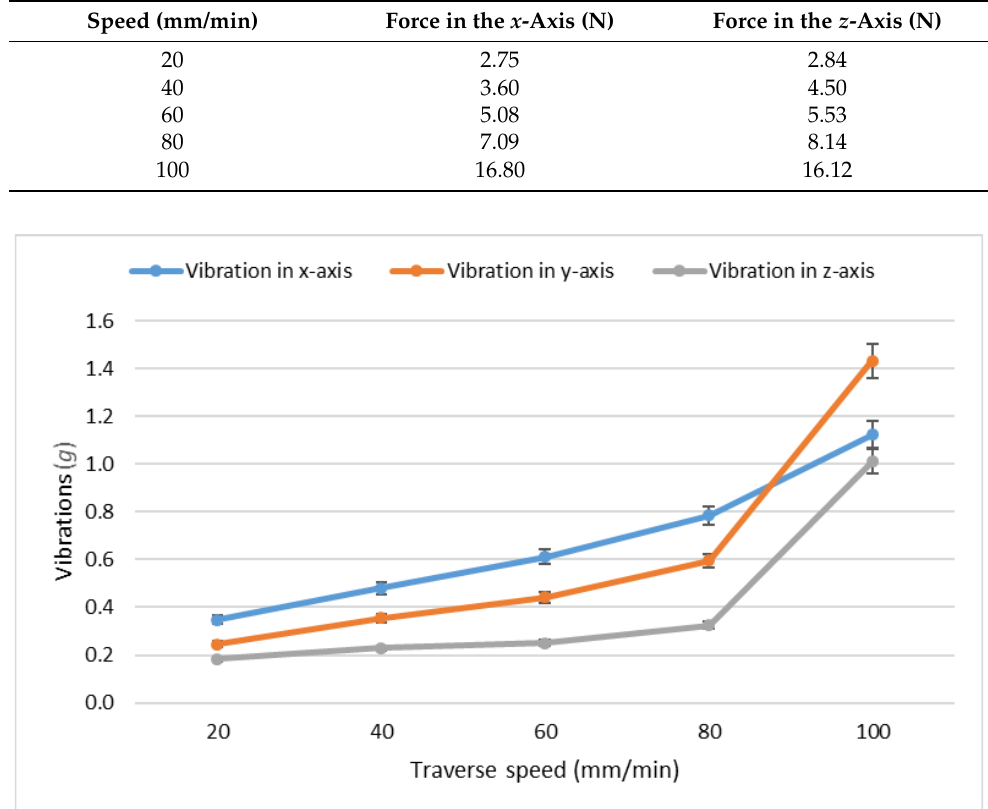
Table 11. Measured forces on the steel 1.2379 in Newtons. Speed (mm/min) Force in the x -axis (N) Force in the z -axis (N)